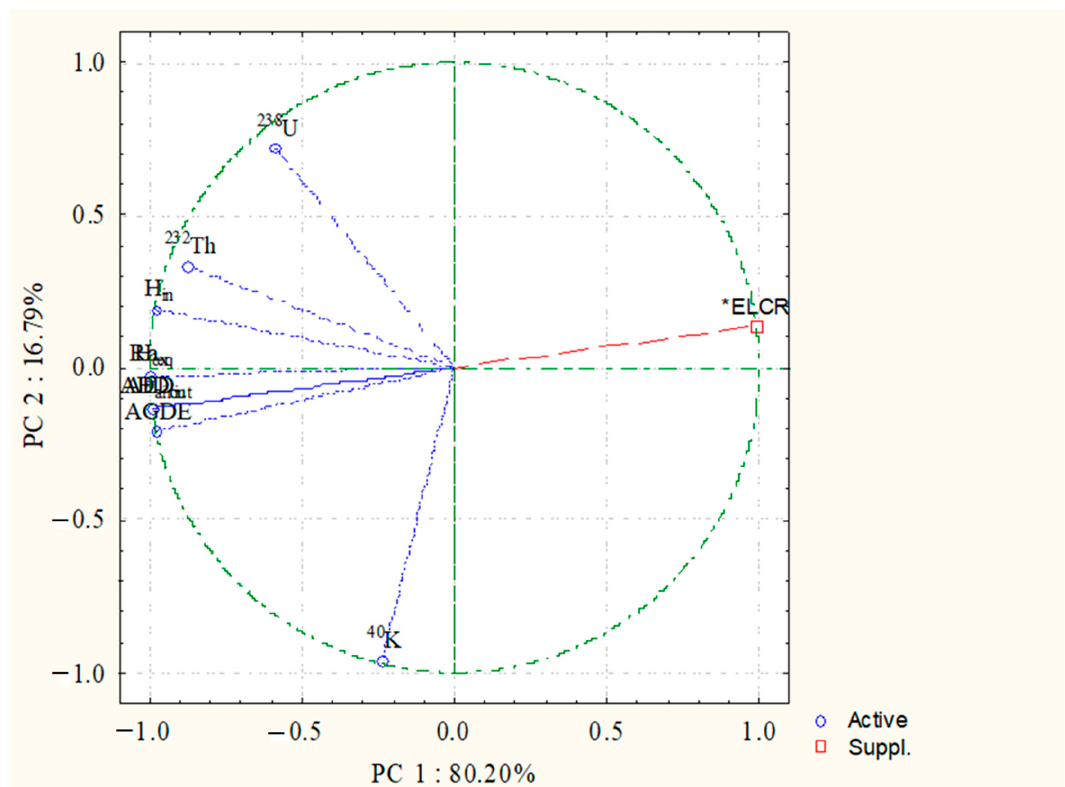
Figure 6. Principal component analysis (PC1 and PC2) for radiological data at studied area.